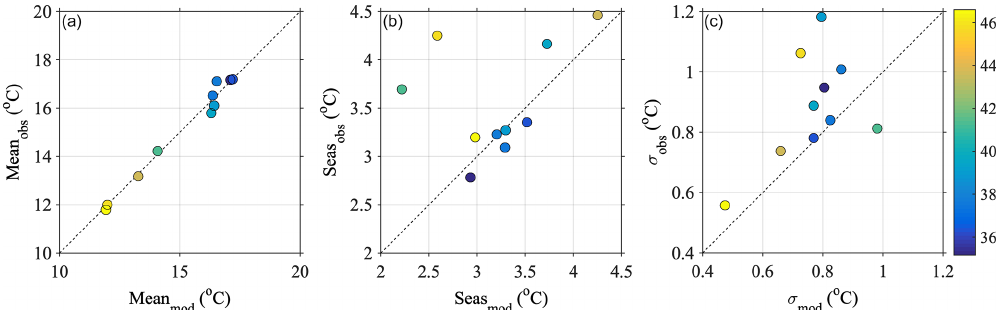
Figure 14. Primary statistics of coastal water temperature in the model ( x axis) and observations ( y axis): time-mean temperature (a) , amplitude of seasonal harmonic (b) and standard deviation of daily temperature anomaly (c) . Colours denote the latitude of the coastal measurement station